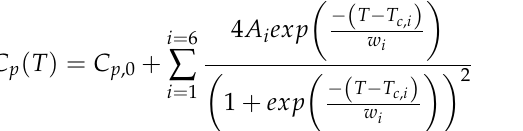
1). They were recruited at the same Annunziata Hospital (21 subjects) or among blood